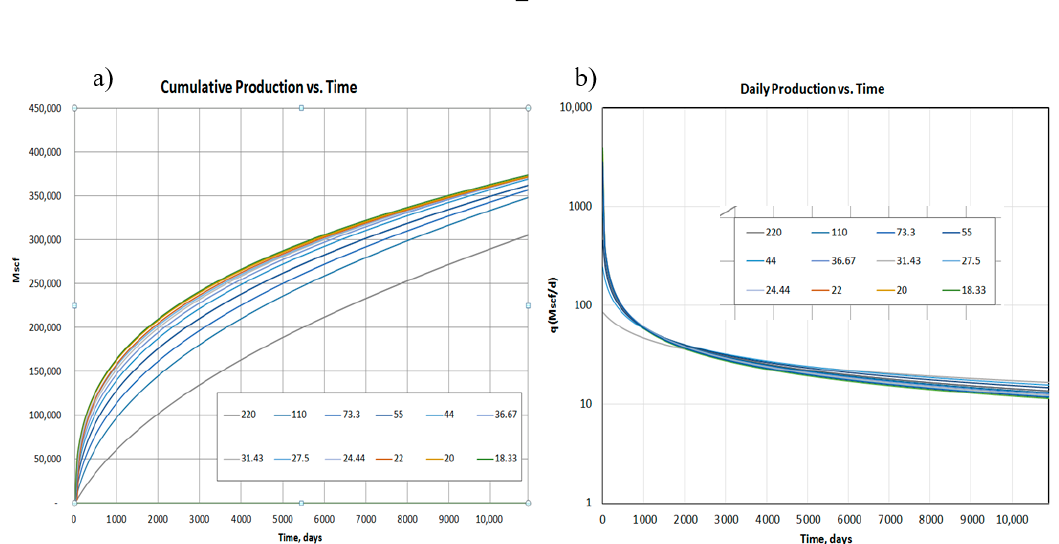
Figure 10. Flow-cell model-based production performance forecasts for Utica wells with fracture spacing ranging between 220 and 18.3 ft (Table 1). The base case performance is for the Utica type well with 55 ft fracture spacing. The impact of wider and narrower fracture spacing on well productivity is graphed for both ( a ) the cumulative, and ( b ) daily production rates.